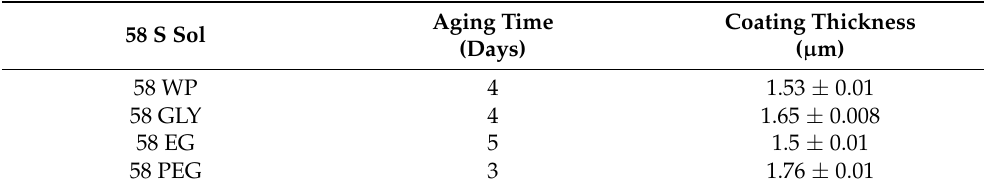
Table 1. Aging time of the different 58S sols and thickness of 58S coatings on glass-slide prepared with and without